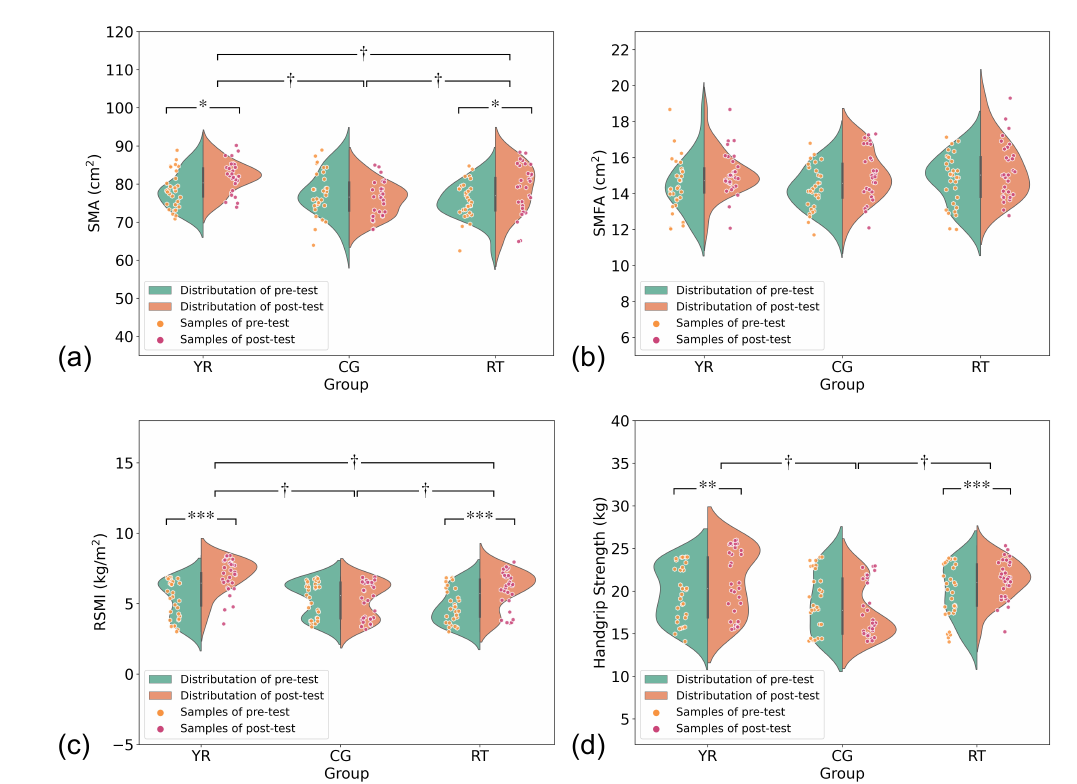
Figure 4. A scatter plot with a rotated kernel density plot on each side showing the changes in L3 SMA, L3 SMFA, RSMI, and handgrip strength in older patients with sarcopenia at baseline and after the intervention. ( a ) L3 SMA, ( b ) L3 SMFA, ( c ) RSMI; ( d ) handgrip strength. YR indicates Yi Jin Jing and resistance training group; RT indicates resistance training group; CG indicates control group. * p < 0.05, ** p < 0.01, *** p < 0.001 the significance of intragroup differences, † the significance difference among groups ( p <